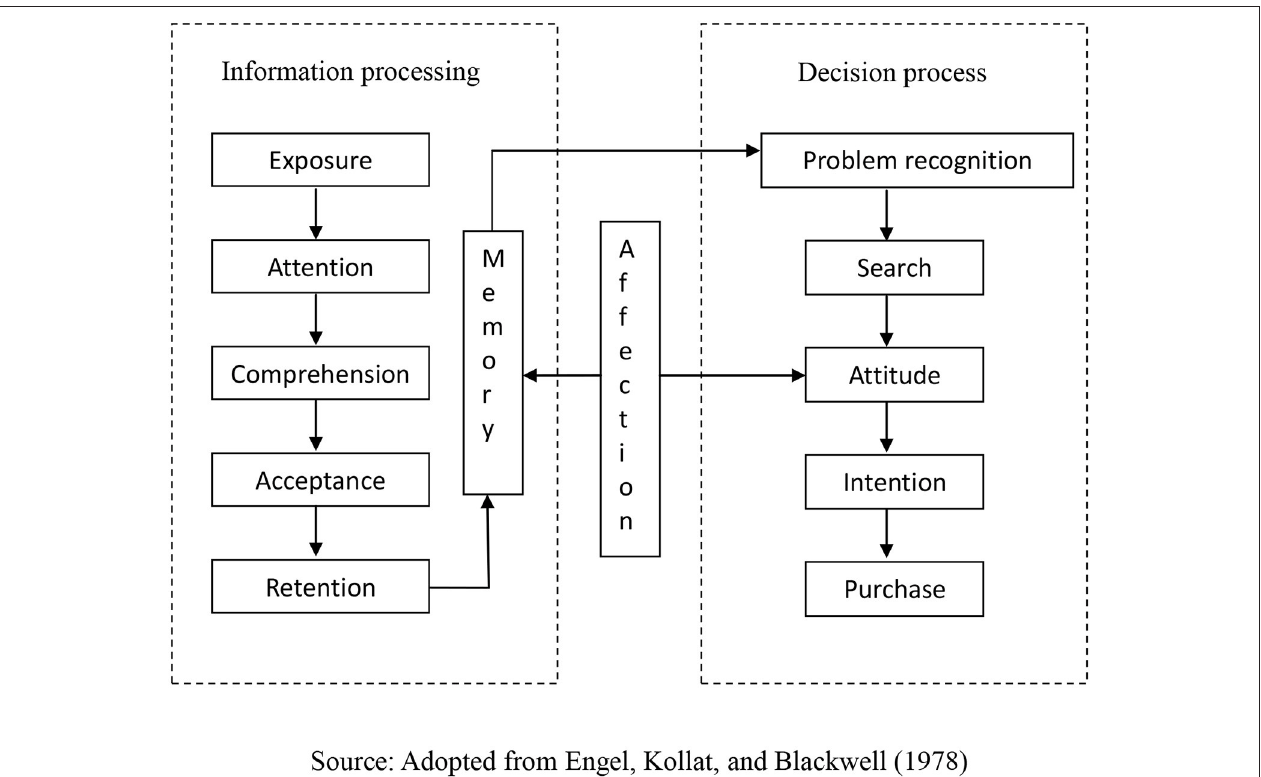
FIGURE 1 | A modified model of story stimuli on consumer